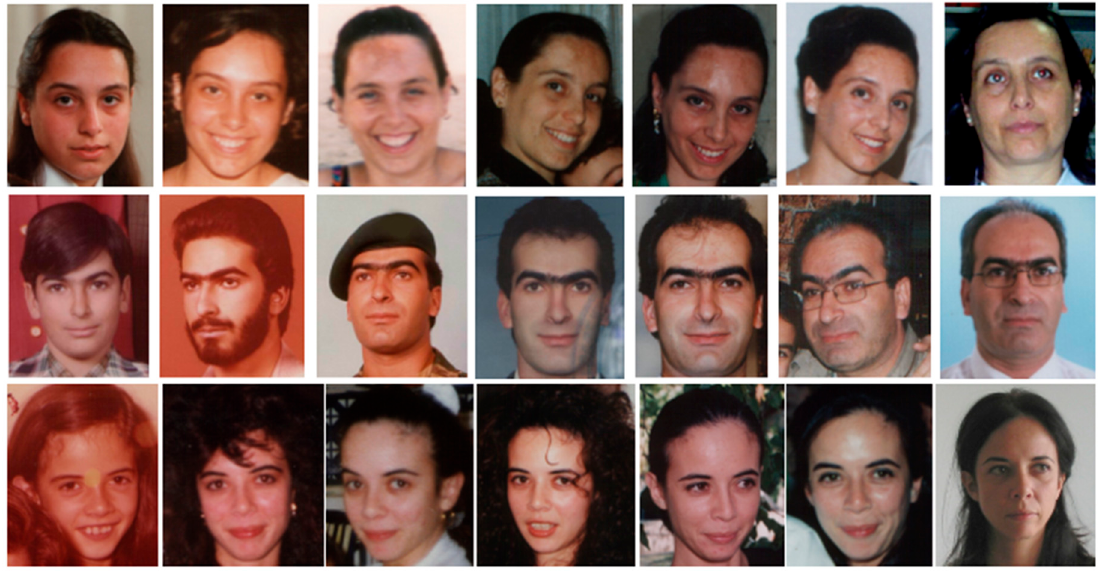
Figure 6. Cross-age original facial images of three people.